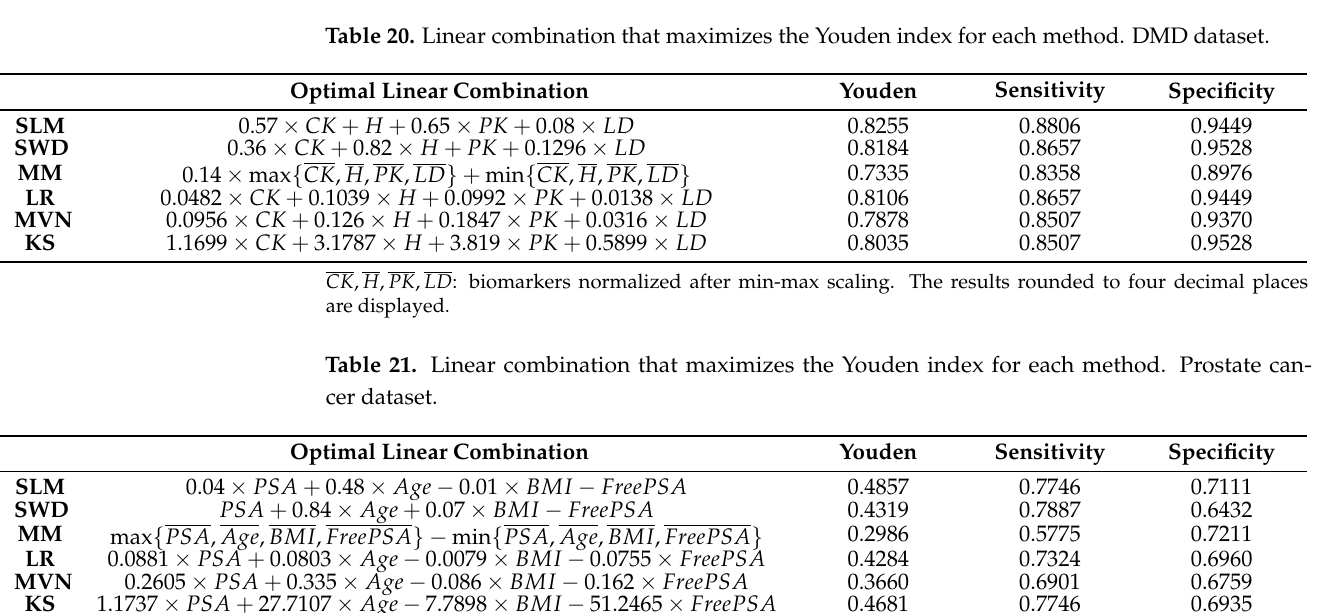
Table 22. Ten-fold cross validation. DMD dataset.